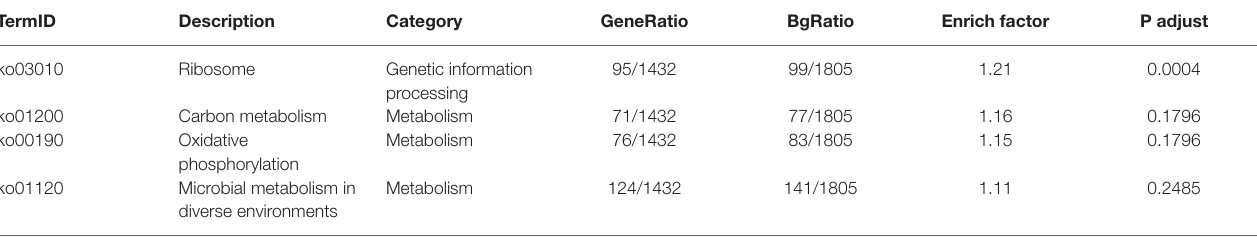
TABLE 1 | KEGG enrichment analysis of S. sclerotiorum in paired comparison of Gm-Ba-Ss vs. Gm-Ss. TermID